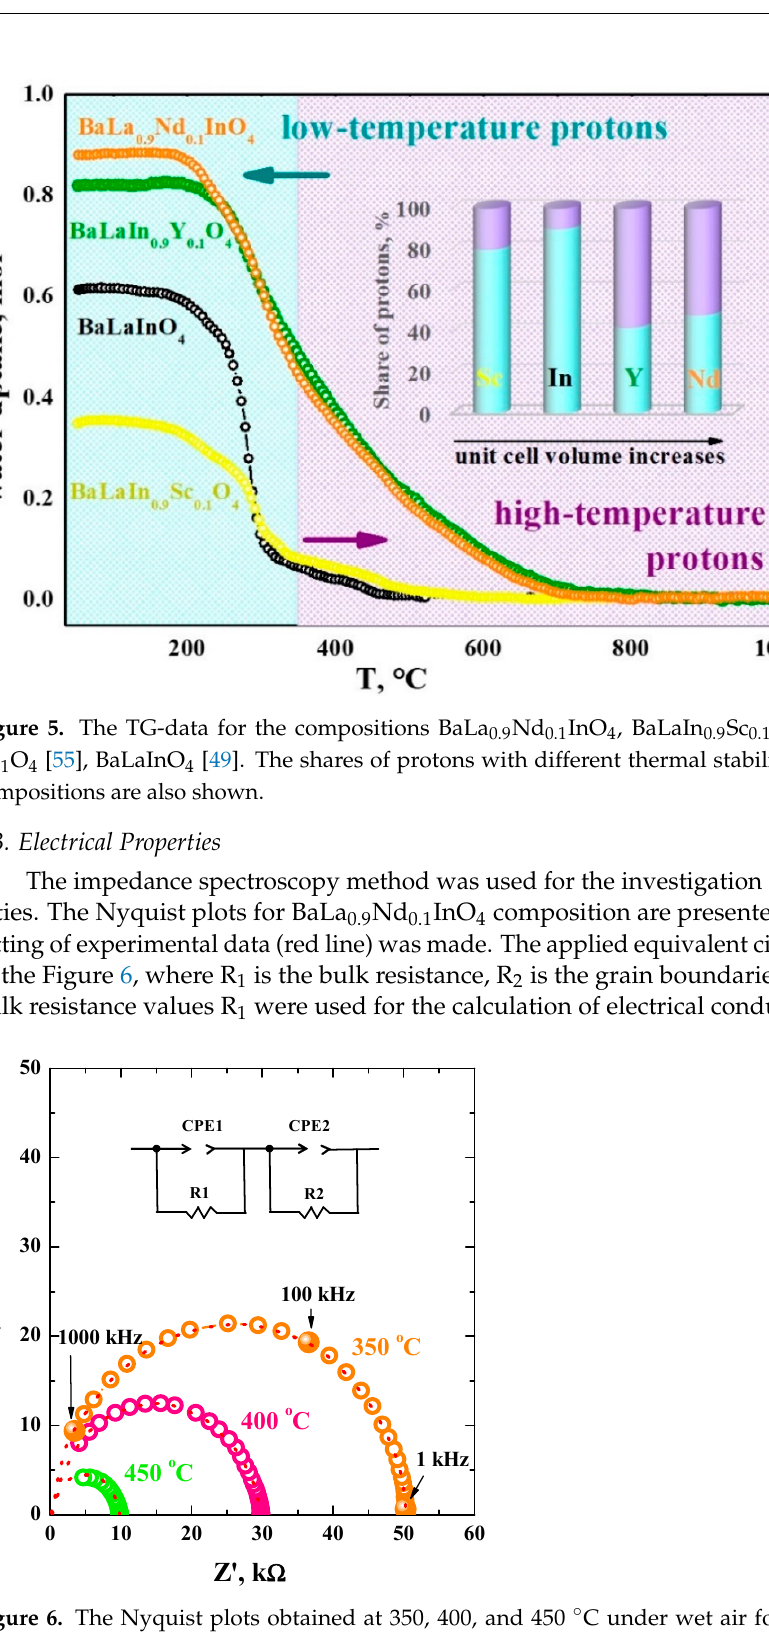
Figure 6. The Nyquist plots obtained at 350, 400, and 450 °C under wet air for the composition BaLa 0.9 Nd 0.1 InO 4 .